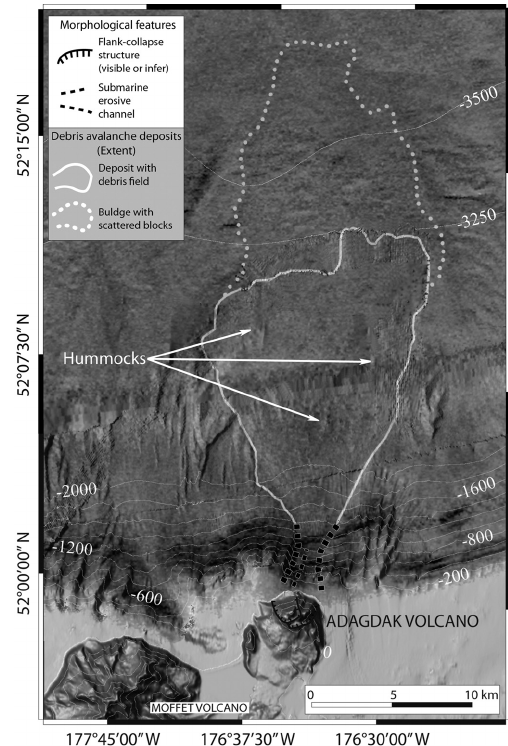
Fig. 9. Topography, bathymetry and Gloria side-scan data of Adag- dak volcano and its northern submarine portion. For side scan data the black is high backscatter and white is low backscatter. Contour interval is